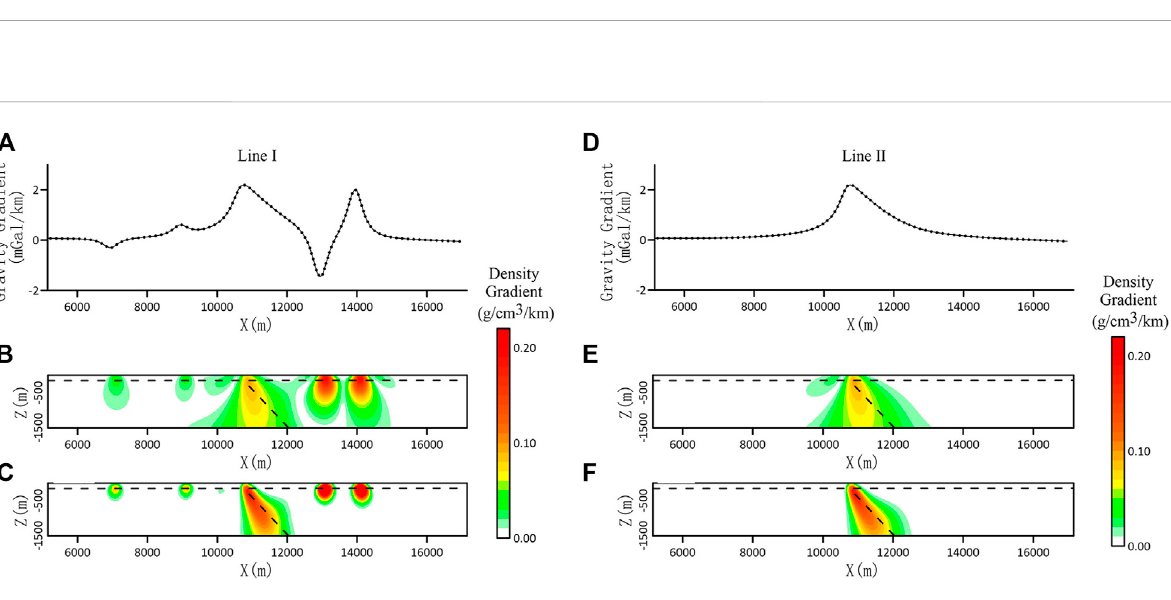
FIGURE 8 Horizontal gradient curve of gravity in the x-direction and inversion result in the pro fi le of the density gradient on line I. (A) Horizontal gravity gradient anomaly curve of line I. (B) Slice the inversion result of line I without focusing constraint. (C) Slicing of line I focusing inversion results. (D) Horizontal gravity gradient anomaly curve of line II. (E) Slice the inversion result of line II without focusing constraint. (F) Slicing of line II focusing inversion